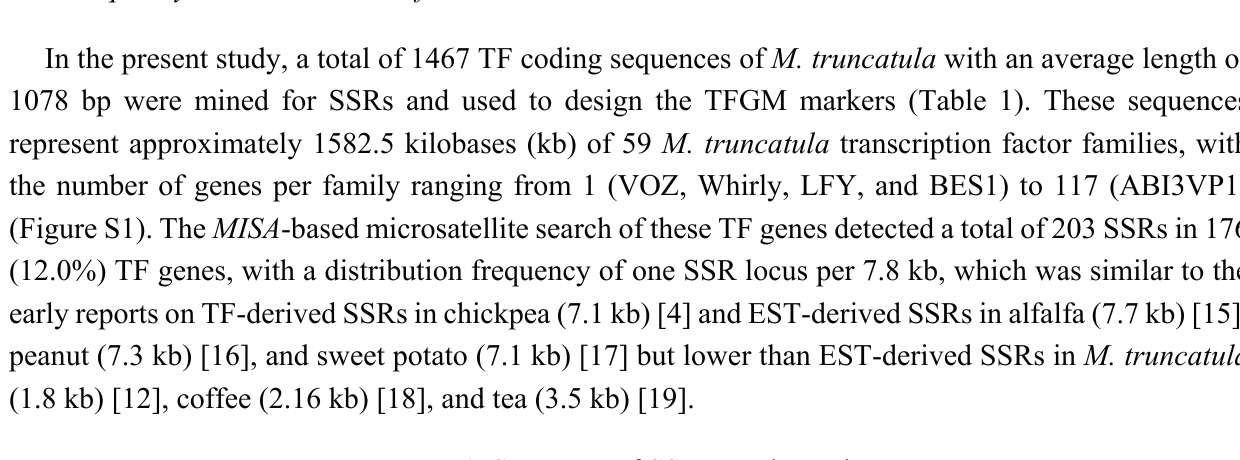
Table 1. Summary of SSR search